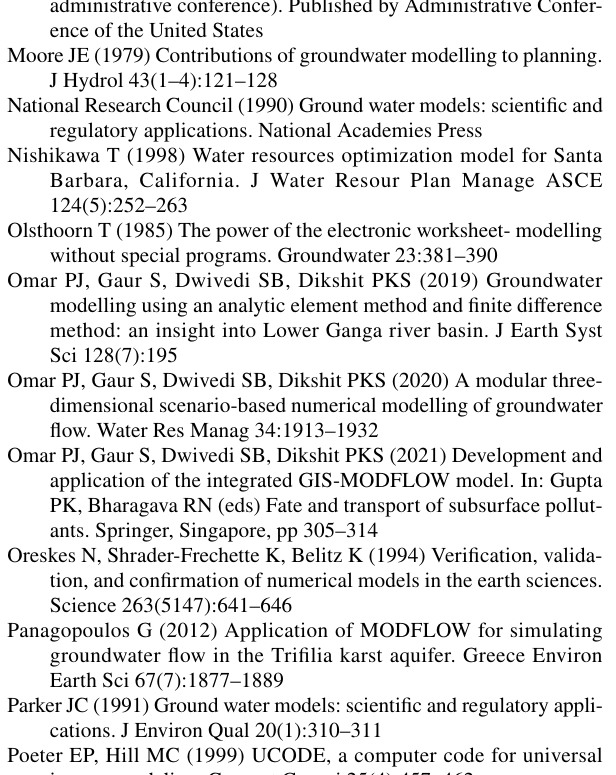
table variability and trend using ordinary kriging: the case study of Sylhet. Bangladesh App Water Sci 11(7):1–12 Heinzer T, Hansen DT (1999) Development of a graphical user inter- face in GIS Raster Format for the finite difference groundwater model code, MODFLOW. ASTM, pp 239–249 Hill MC (2006) The practical use of simplicity in developing